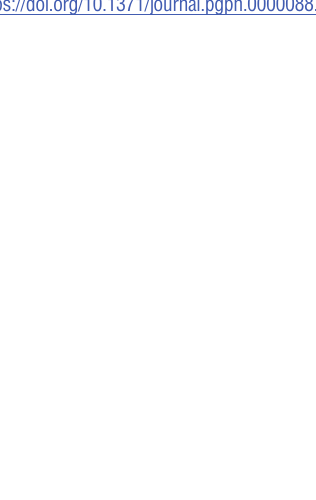
Fig 2. Modified PRISMA diagram showing articles reviewed and main reasons for exclusion.